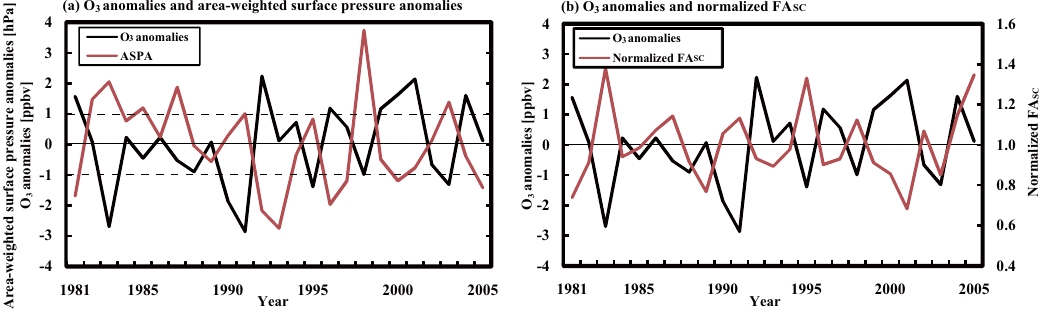
Fig. 9. (a) Time series of springtime BL O 3 anomalies over CEC and ASPA between 1981 and 2005. (b) The same as in (a) but with springtime BL O 3 flux anomalies across the section along L SC (FA SC ). See Fig. 1 for the definition of L SC . Values of FA SC are normalized relative to the 25-year average. The simulation scenario and the definition of anomalies are the same as in Fig. 6.